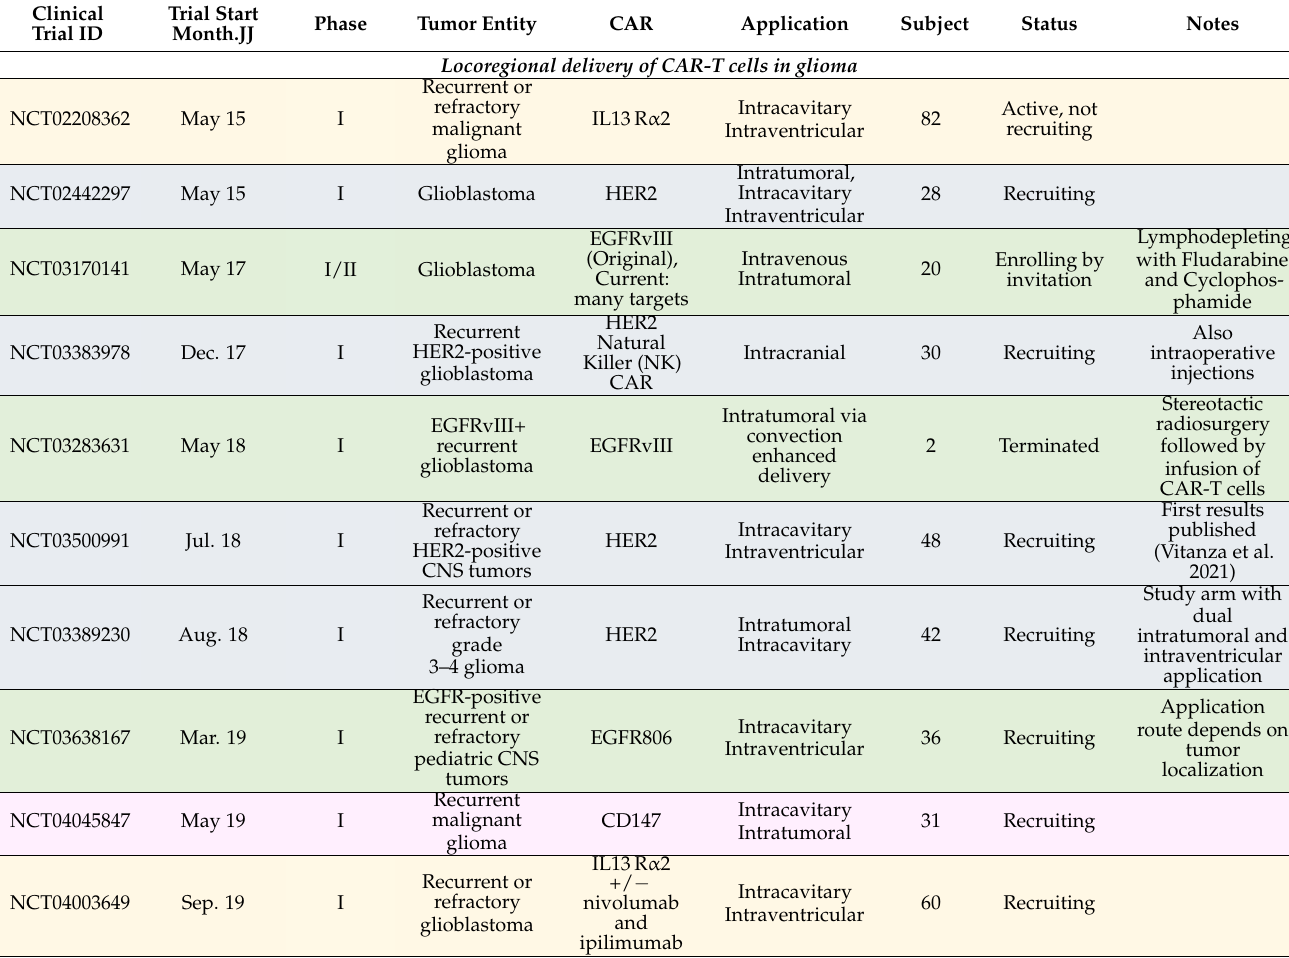
Table 2. Ongoing clinical trials involving CAR-T cell therapies in malignant gliomas. Clinical Trial Start Trial ID